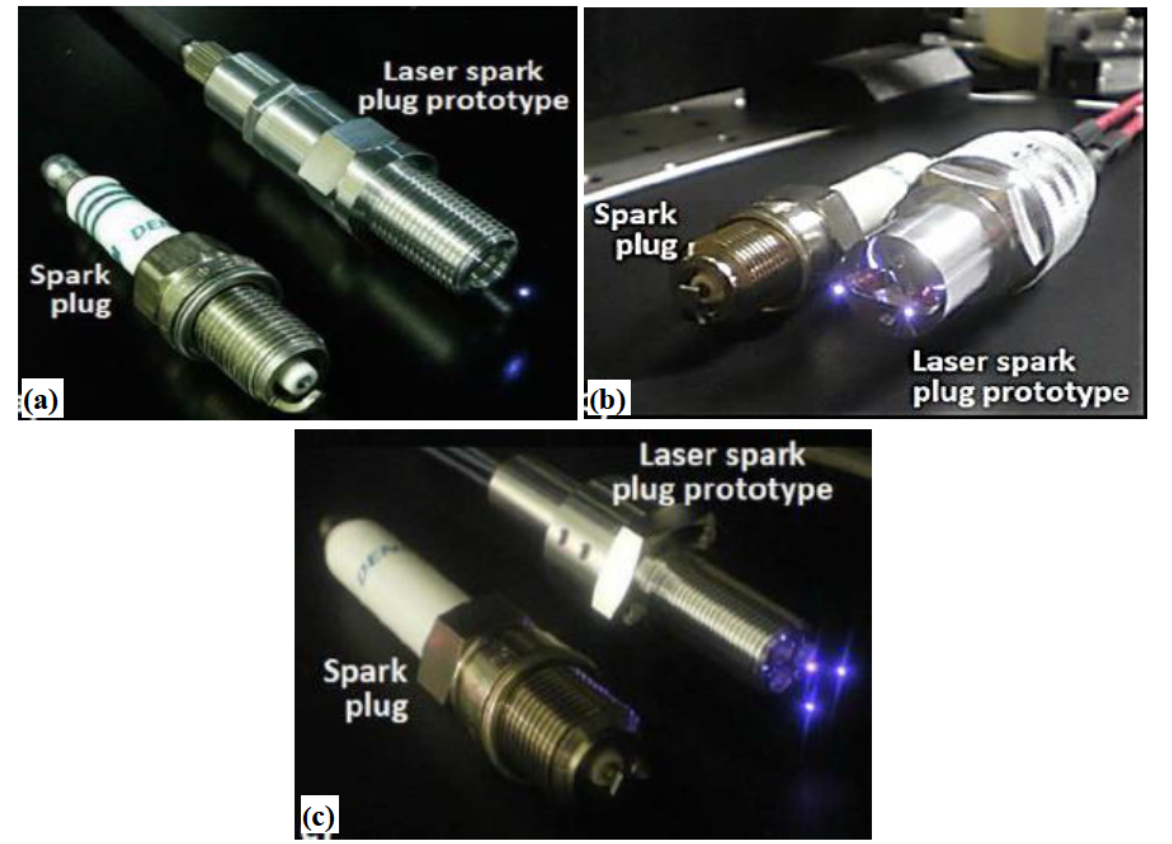
Figure 14: View of laser spark plug prototypes developed at IMS, Okazaki, Japan; single-beam solution with discrete elements (Nd:YAG, Cr4þ:YAG single-crystals and resonator mirrors) (a), two-beam solution based on composite all-ceramics Nd:YAG/Cr4þ:YAG in monolithic design (b) and three-beam solution (c)